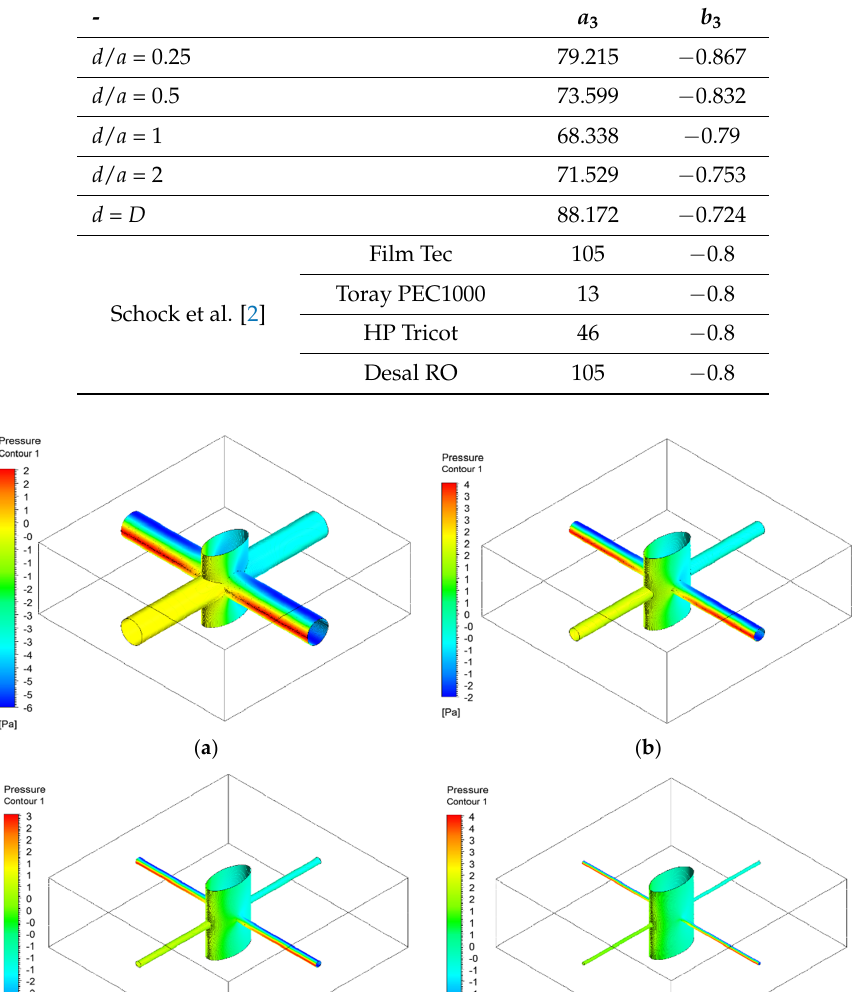
Figure 9. The friction factor, associated with the connecting filament diameter, as a function of the Reynolds number. A comparison was made with the friction factor results of Haaksman et al. [23]. Table 2. The friction factor function parameters.